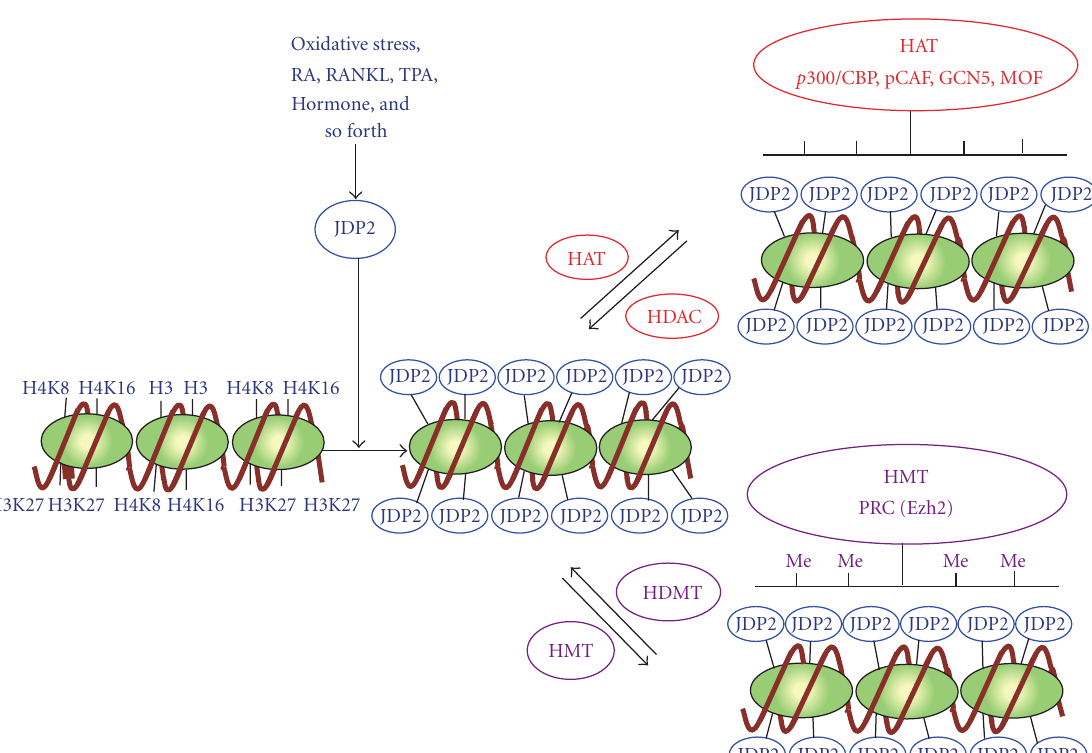
Figure 4: Model for the epigenetic regulation by JDP2. During the exposure of cells with oxydative stress, retinoic acid (RA), RANKL, TPA, and adipocyte inducing hormones, the histone H3, H4K8, and H4K16 as well as H3K27 were masked by JDP2 proteins and prevent the attack of histone modification enzymes like HAT (p300/CBP, pCAF, GCN5, MOF, etc.) and HMT (Ezh2 etc) in the cellular senescence and cell di ff erentiation. This is a novel mechanism of JDP2 to inhibit the histone modification. The gene locus is either the p16 Ink 4 a / Arf locus or C/EBP δ